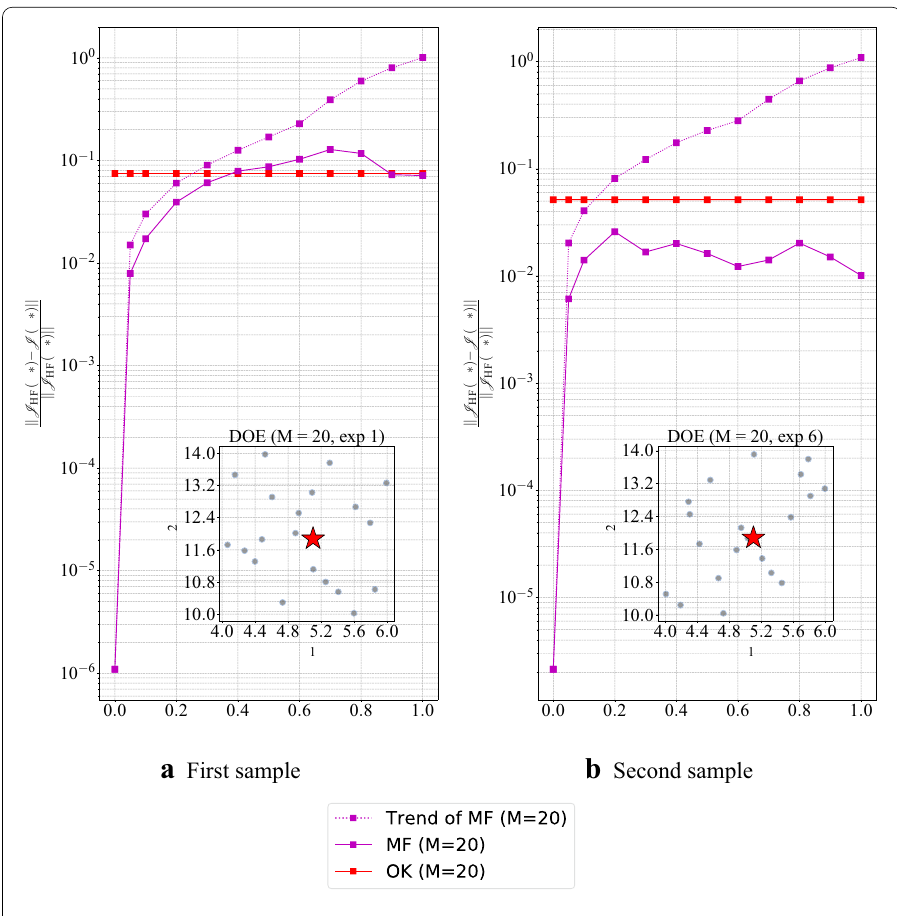
Fig. 6 Evolution of the relative error for a sample experiment. The black dots are the DoE points and the red star is the location of the theoretical optimum of the HF